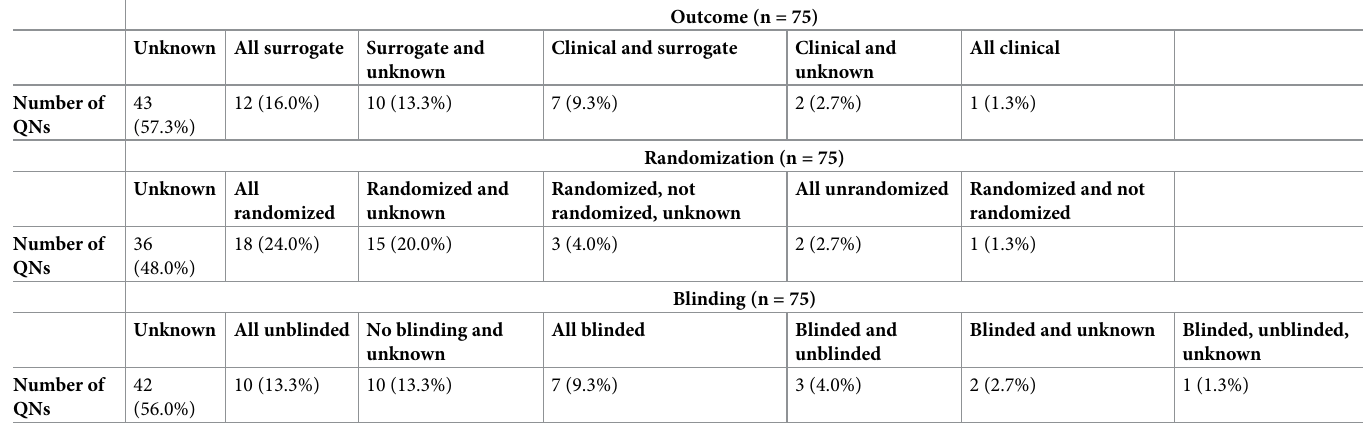
Table 1. Study methodology in individual Qualifying Notices